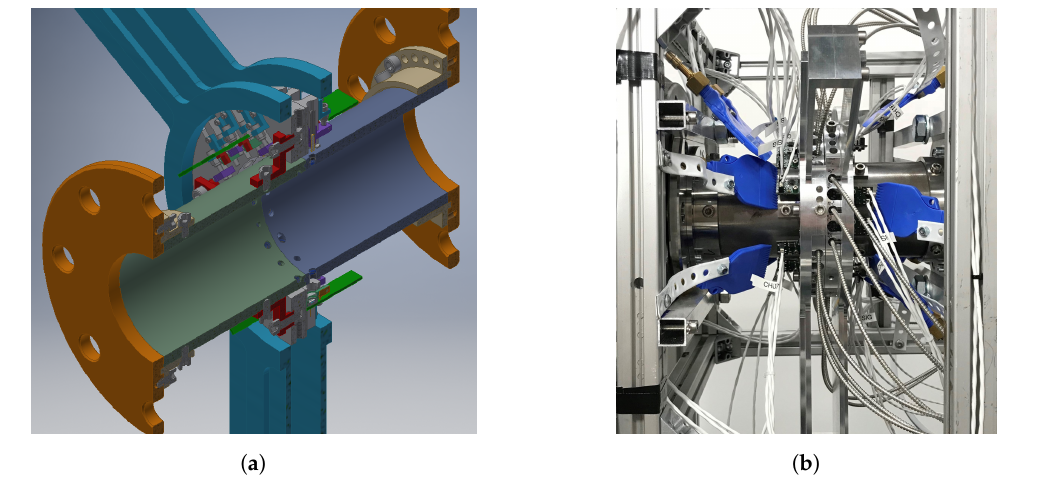
Figure 8. Measurement system prototype; ( a ) CAD sectional model showing the structure of the inner pipe and the detection ring; ( b ) prototype installed on the hot gas test bench measuring the gas distribution of a urea injection experiment.